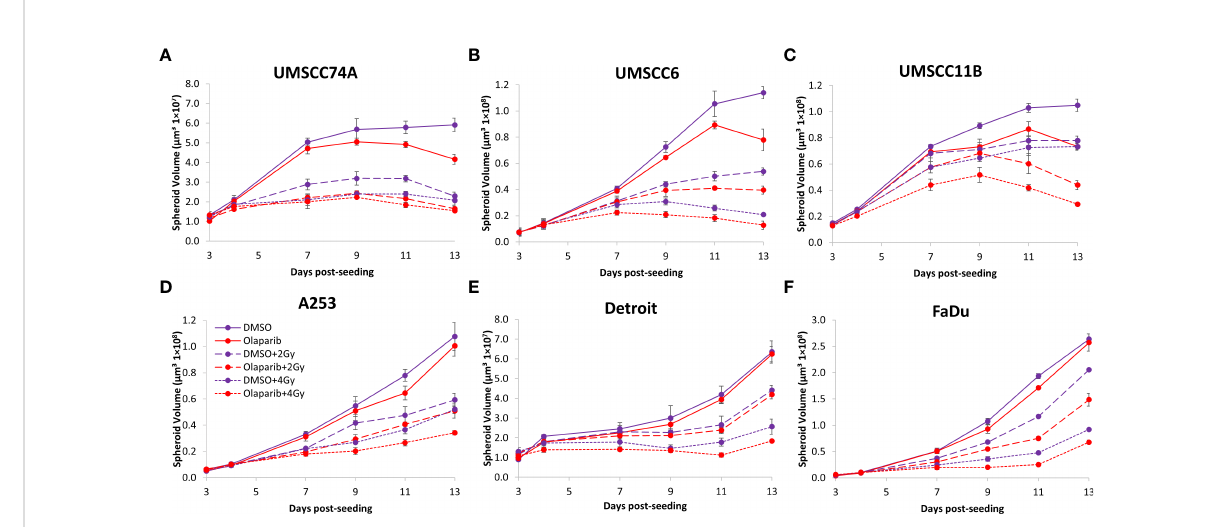
FIGURE 7 Impact of olaparib on the radiosensitivity and growth of HPV-negative HNSCC spheroids in response to protons. Spheroids were allowed to develop for 24 h in ultra-low-attachment plates, treated with DMSO or olaparib (0.1 µM) for a further 24 h, and then unirradiated or irradiated (2 or 4 Gy) on day 3 with a single dose of protons. Growth of spheroids derived from cells from (A, B) the oropharynx (UMSCC74A and UMSCC6), (C) the larynx (UMSCC11B), (D) the salivary gland (A253), and (E, F) the hypopharynx (Detroit 562 and FaDu) was measured by microscopy up to 13 days post-seeding and analysed from three biologically independent experiments.